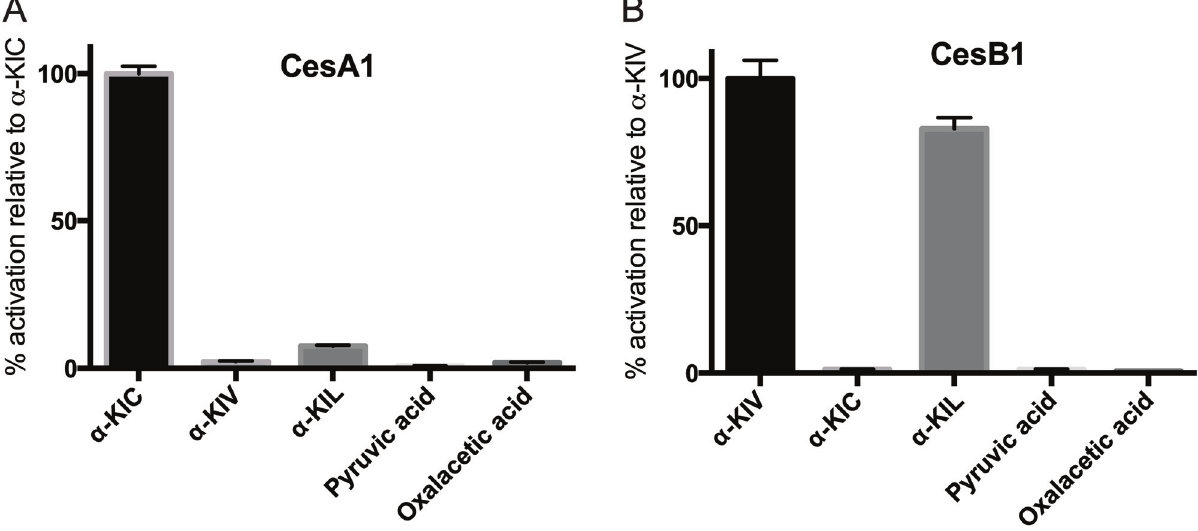
Fig 5. Evaluation of α -keto acid side chain selectivity of cereulide synthetase. The ATP-PPi exchange assay was performed with CesA1 (A) and CesB1 (B) and various α -keto acids as substrates, in triplicate. See S1 Fig for a comprehensive list of the monomers, their abbreviations, and their structures. Data was normalized to the activity obtained with the cognate